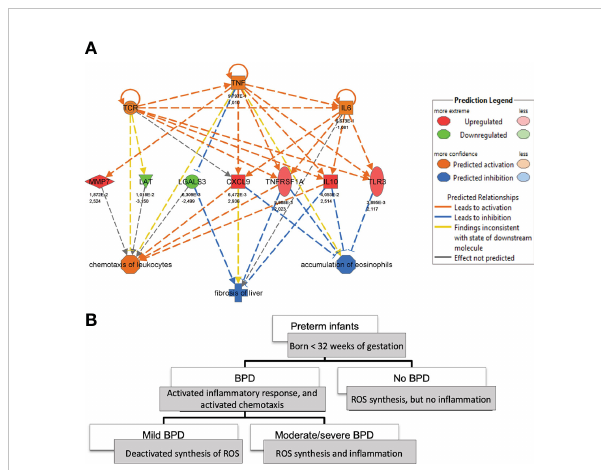
FIGURE 2 Tracking of monocyte-related cytokine expression in BPD at birth. (A) : Regulator-effects-network highlighting the role of TNF a in mild BPD (n=6) in comparison to no BPD (n=13) at birth. The network is derived from Ingenuity Pathway analysis of the transcripts differentiating between BPD severity grades (up- and downstream). (B) : The comparison of downstream effects of transcripts, able to predict BPD severity grades at birth, demonstrates involvement of in fl ammatory response, chemotaxis, and synthesis of Reactive Oxygen species (ROS) depending on BPD